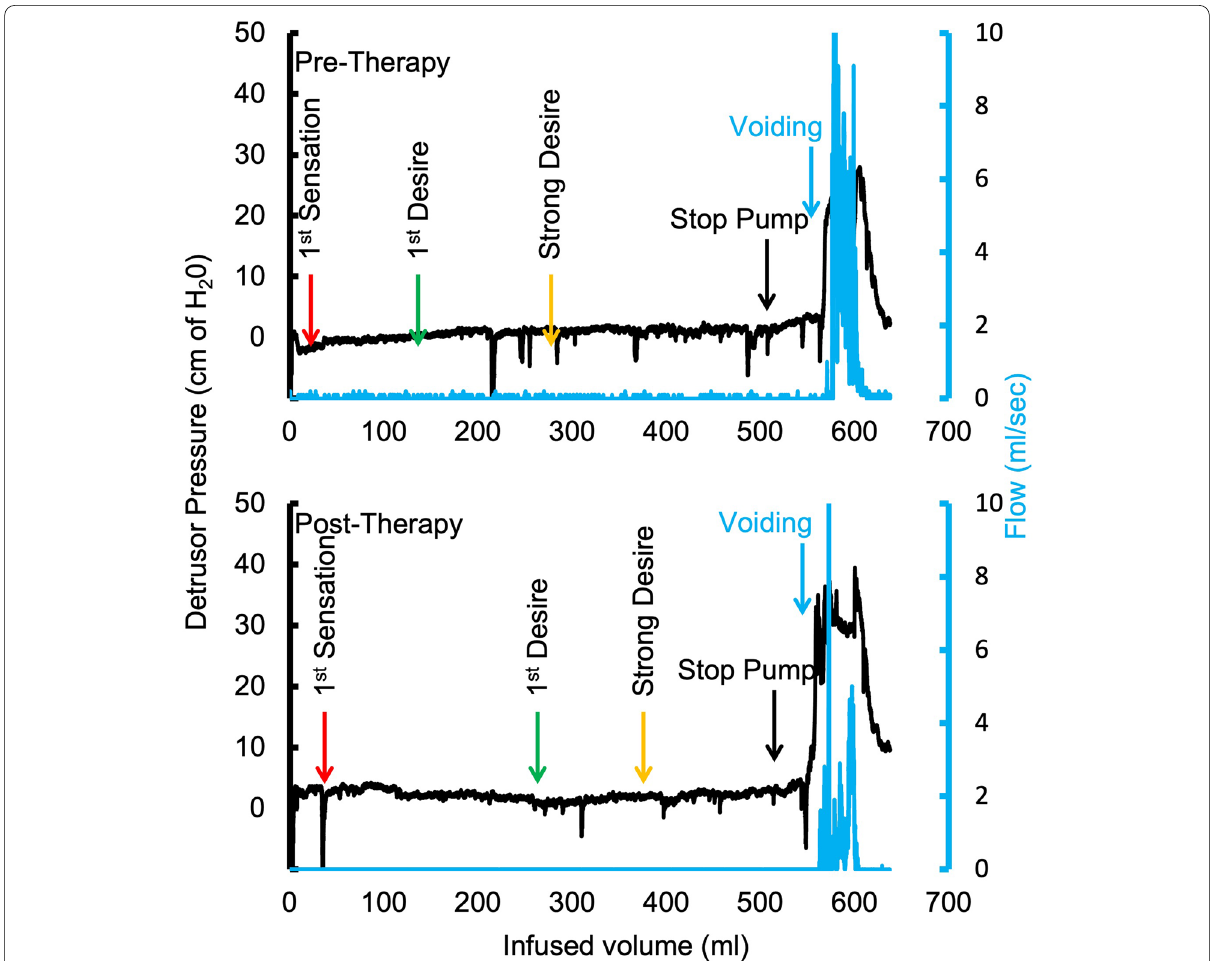
Fig. 4 A representative Urodynamic study from a patient before and after 12 weeks of therapy. Note the while the overall bladder capacity remained the same, the changes in 1st desire and strong desire relative to beginning of voiding demonstrates the increased bladder and sphincter control